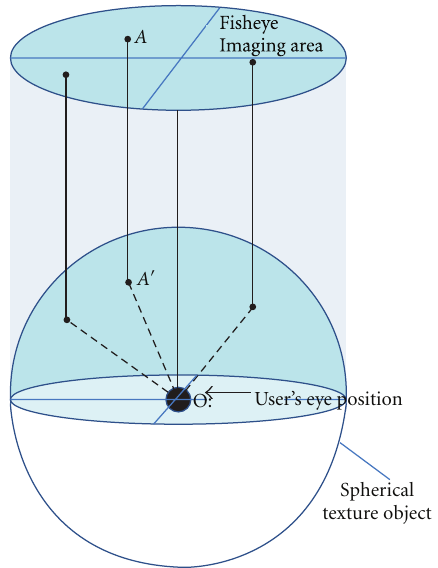
Figure 7: Texture mapping for distortion correction.